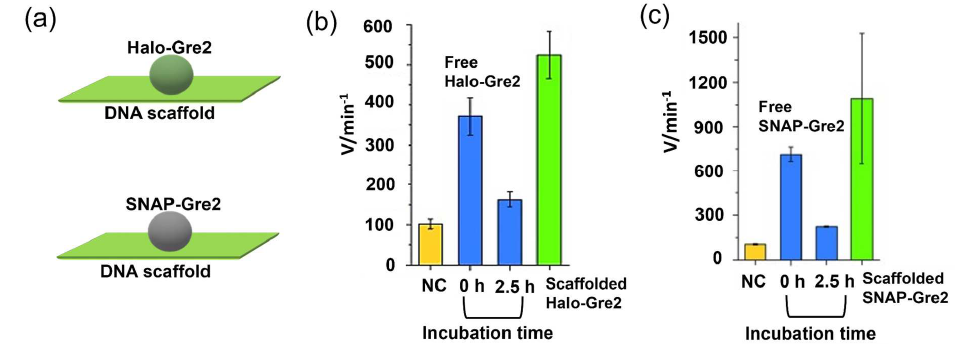
Figure 4. The S -selective NADP + /NADPH-dependent oxidoreductase Gre2 was assembled on the DNA scaffold with the study of protection effect of scaffold [71]. ( a ) Enzyme Gre2 was fused to Halo-tag or SNAP-tag to obtain Halo-Gre2 or SNAP-Gre2, which was then assembled on the DNA scaffold. ( b ) Comparison of reaction velocities estimated for DNA scaffolded Halo-Gre2 (green bar) as well as free Halo-Gre2 (blue bars), freshly prepared (0 h) or incubated for 2.5 h. NC (negative control) indicated the sample containing buffer only. ( c ) Comparison of reaction velocities estimated for DNA scaffolded SNAP-Gre2 (green bar) as well as free SNAP-Gre2 (blue bars), freshly prepared (0 h) or incubated for 2.5 h. NC (negative control) indicated the sample containing buffer only. Reprinted with permission from Ref. [71]. Copyright 2015 John Wiley and Sons.